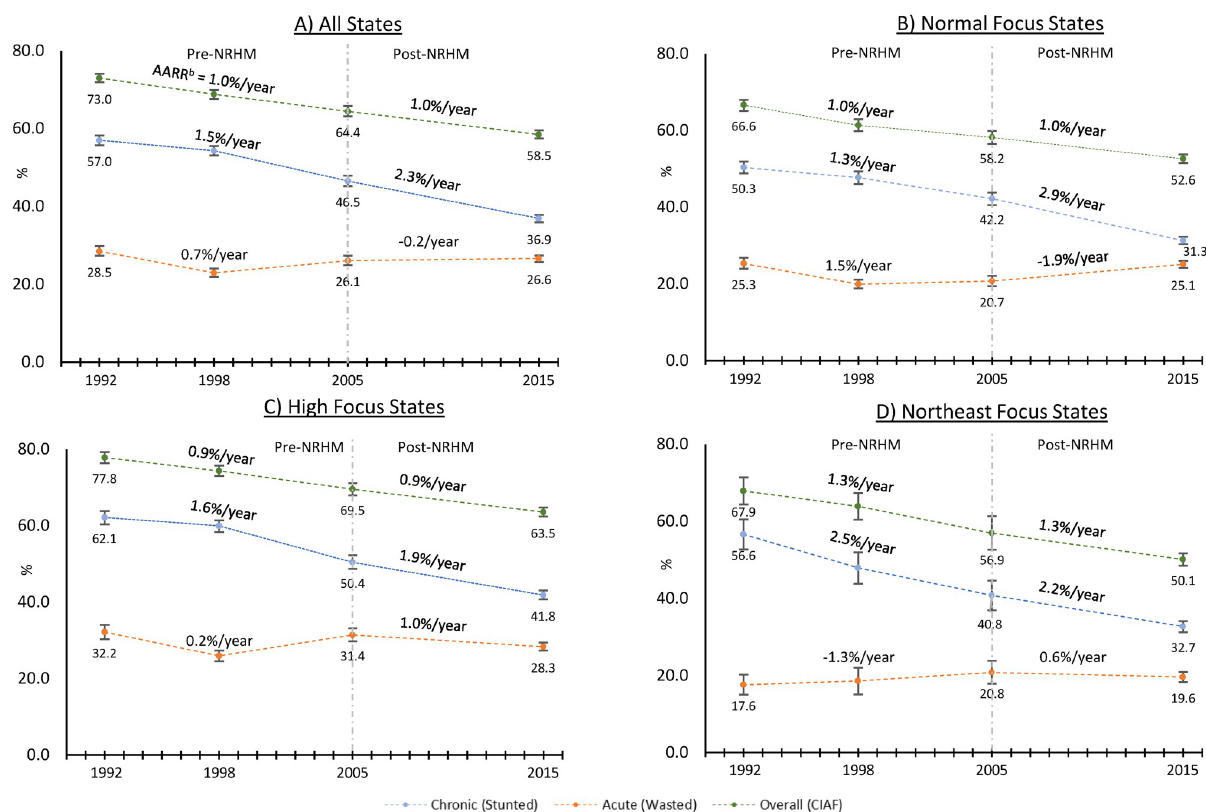
Fig 2. Change in the prevalence of undernutrition among Indian children aged 3 or less. Data from the 1992, 1998, 2005, and 2015 NFHS. AARR, average annualized reduction rate; CIAF, Comprehensive Index of Anthropometric Failure; NFHS, National Family Health Survey. a: prevalence adjusted for caste, religion, and month of survey. b: Average Annualized Rate of Reduction. NRHM: National Rural Health Mission, a national program implemented in 2005 to improve maternal and child health among High focus and Northeast focus states. CIAF: Comprehensive Index of Anthropometric Failure considers a child to be undernourished if the child is either stunted, wasted, or underweight.